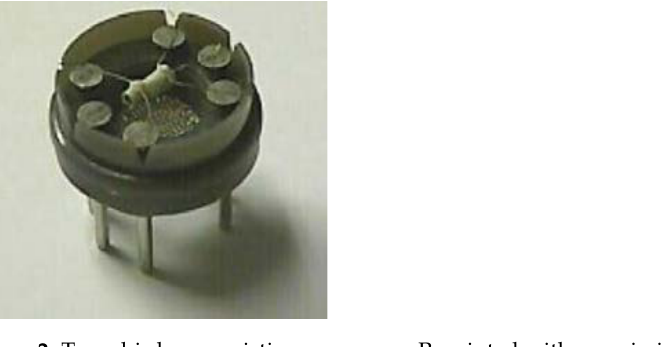
Figure 2. Taguchi chemoresistive gas sensor. Reprinted with permission from Ref. [38]. Copyright 2015, Neri, G.”.